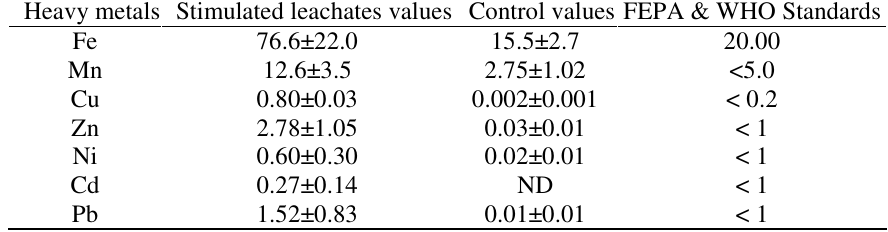
Table 2. The content of heavy metals (mg/L) in stimulated leachate and control samples Heavy metals Stimulated leachates values Control values FEPA & WHO